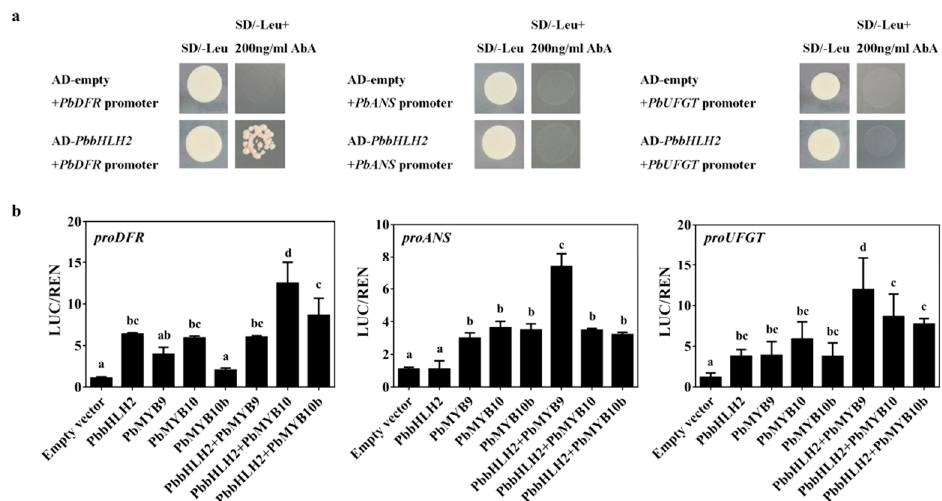
Figure 6. PbbHLH2 interacted with PbMYBs to activate PbDFR and PbUFGT . ( a ) The interactions between the PbbHLH2 protein and the PbDFR , PbANS , and PbUFGT promoters as revealed by yeast one-hybrid assays. The yeast transformed with plasmid AbAi-promoters and plasmid AD-PbbHLH2 which grew on SD/-leu plate were used as positive controls; the yeast transformed with plasmid AbAi-promoters and empty plasmid AD which grew on SD/-leu + 200 ng/mL AbA plate were used as negative controls. ( b ) Transient dual-luciferase detections of PbDFR , PbANS , and PbUFGT promoters in Nicotiana benthamiana leaves. Different letters denote statistical significance (one-way ANOVA, p < 0.05). Values are means ± SDs, n =